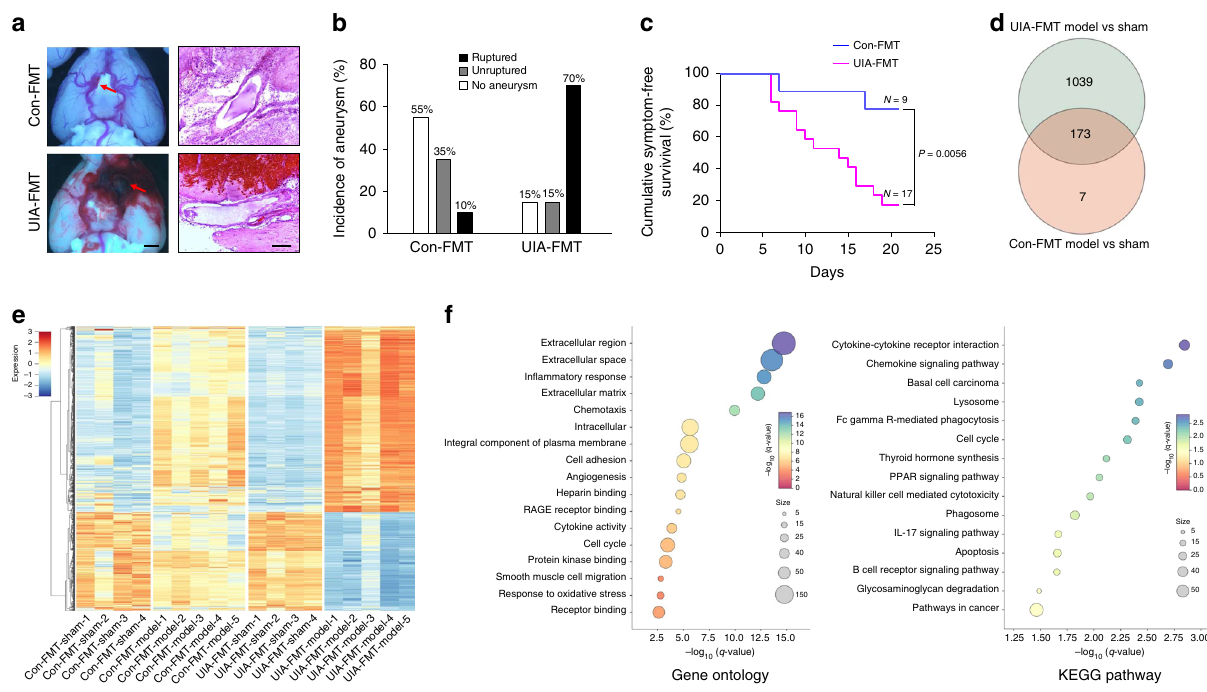
Fig. 5 UIA gut microbiota contributes to the intracranial aneurysms. a Representative images of intracranial aneurysms (left; arrows, aneurysms; scale bar, 1 mm) and cerebral arteries stained with hematoxylin-eosin (right; scale bar, 100 μ m) in mice that received fecal microbiota transplantation (FMT) from UIA patients or controls, followed by aneurysm induction with angiotensin II and elastase. Independent experiments were repeated at least fi ve times. b Incidence of unruptured and ruptured aneurysms 21 days after induction ( n = 20). c Cumulative symptom-free curves for mice with aneurysms showing the time course of the onset of symptoms ( n = 9 for control-FMT group, n = 17 for UIA-FMT group; log-rank (Mantel – Cox) test). d Venn diagram of the number of DEGs. Number in cyan circle, DEGs between the aneurysm induction group and the sham group after UIA-FMT. Number in pink circle, DEGs between the aneurysm induction group and the sham group after Control-FMT. e Right, heat maps of cluster analysis showing the transcript expression levels of DEGs in the cerebral vessels of the control-FMT and UIA-FMT groups on day 5 after aneurysm induction. The color scale illustrates the relative expression levels across all samples: orange, above the mean; blue, below the mean. Left, dendrogram showing the clustering of transcripts ( n = 4 for sham groups, n = 5 for aneurysm induction groups). f Top terms showing enrichment based on − log 10 ( q -value) from GO enrichment analysis ( left ) and KEGG pathway analysis ( right ) of the 1039 UIA-FMT-induced DEGs. Source data are provided as a Source Data fi